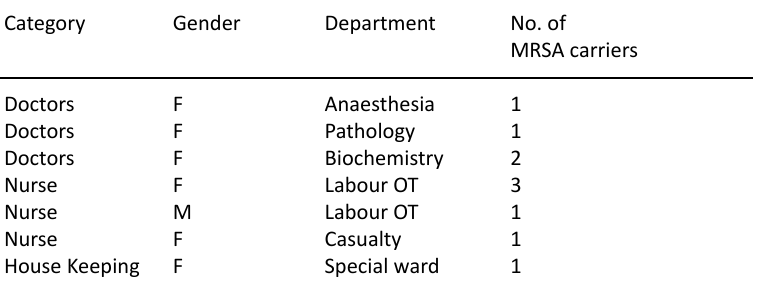
Table 6. Professional category, gender and department wise distribution of MRSA carriers